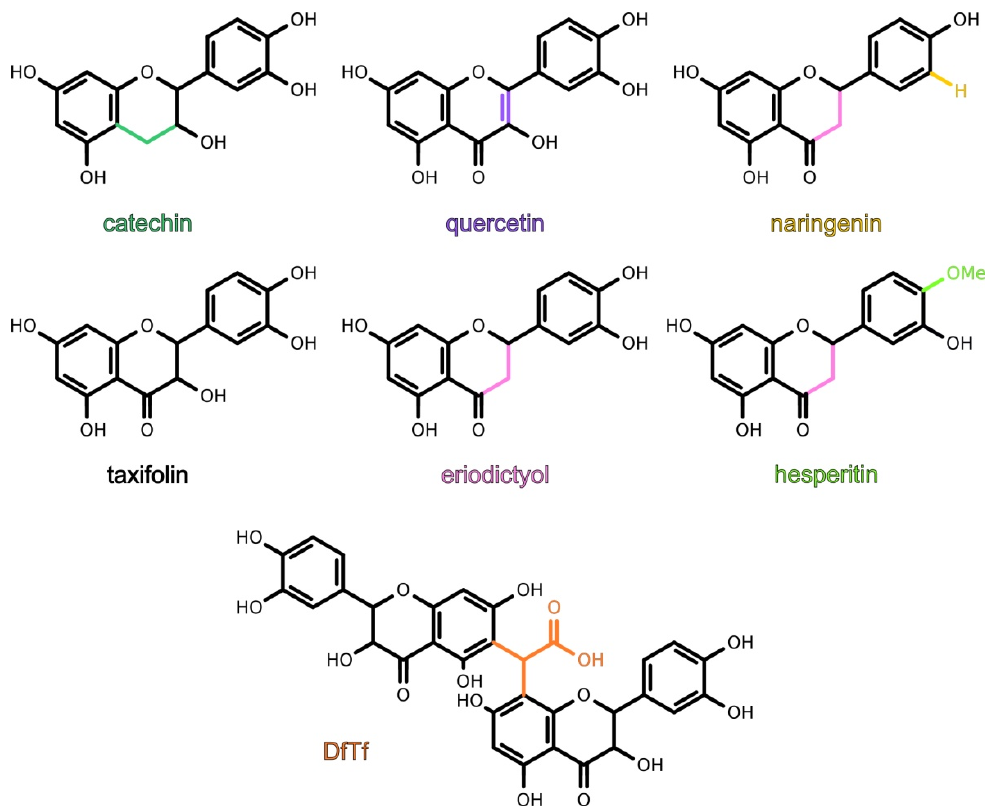
Figure 1. Structures of polyphenols being tested. The product of the condensation of taxifolin with glyoxylic acid is designated as DfTf.